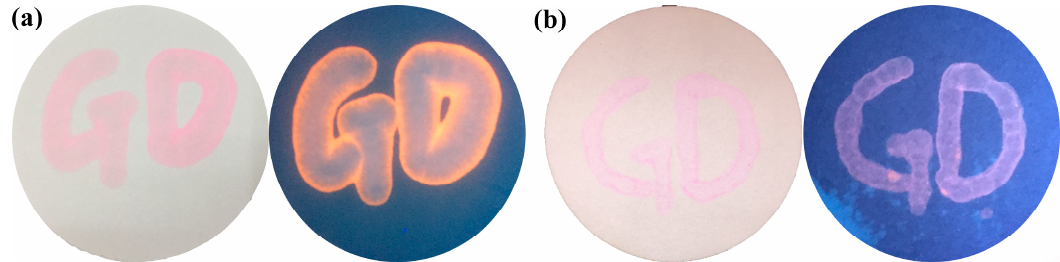
Figure 5. ( a ) Color change of filter paper treated with RB-CT solution (1.0 × 10 − 4 M in CH 3 CN, 3%